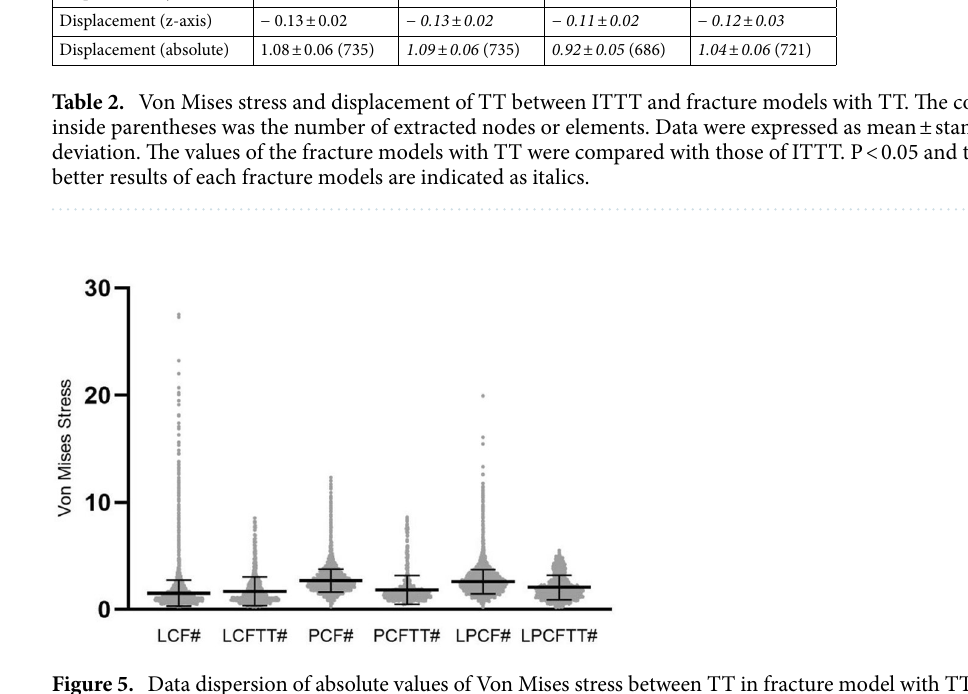
Figure 5. Data dispersion of absolute values of Von Mises stress between TT in fracture model with TT and fragment corresponding fracture model without TT. The unit of Von Mises stress is MPa. LCF# means the stress of fragment of LCF, LCFTT# means the stress of TT in LCFTT, PCF# means the stress of fragment of PCF, PCFTT# means the stress of TT in PCFTT, LPCF# means the stress of fragment of LPCF, LPCFTT# means the stress of TT in